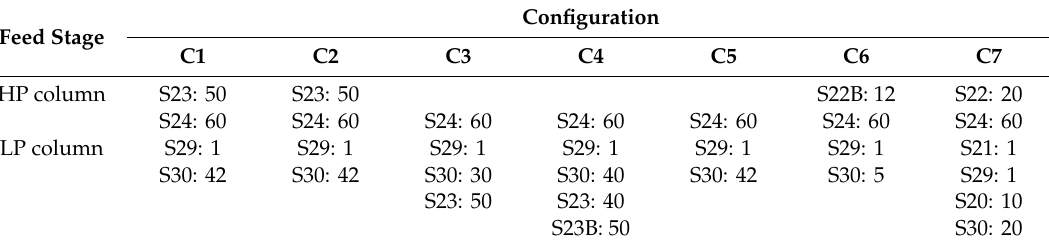
Table 8. Feed stage locations in ASU